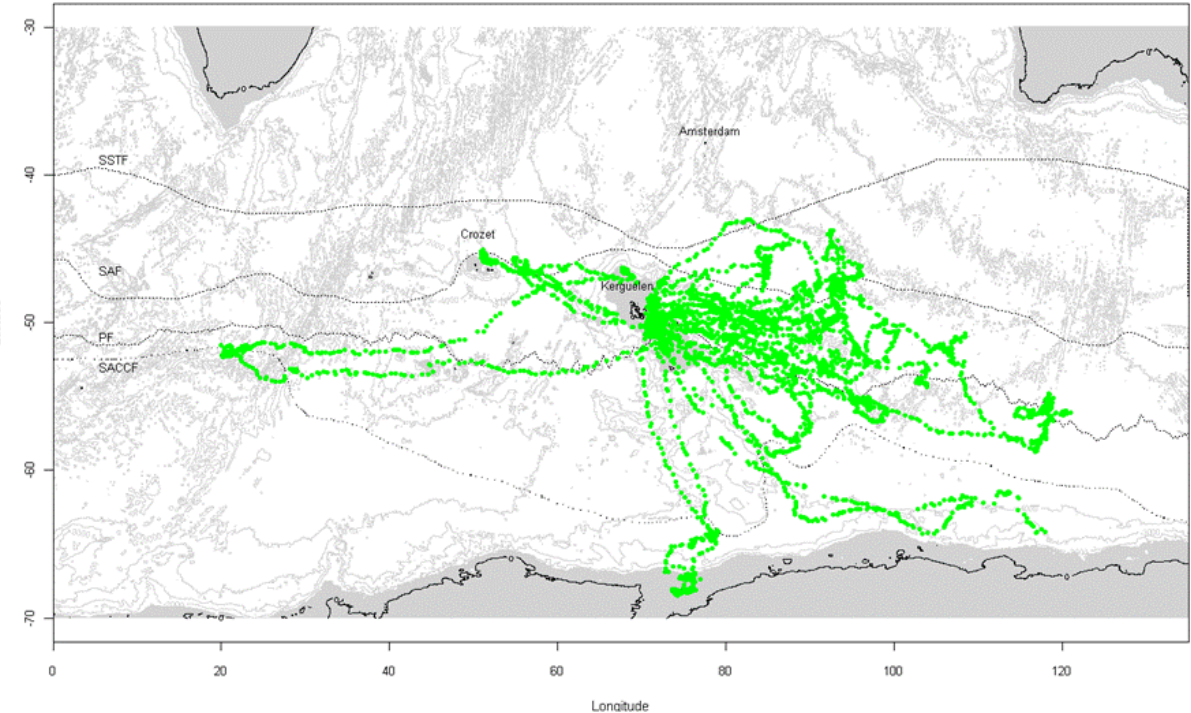
Figure 4. Location of the fluorescence profiles along the tracks of 24 SES successfully equipped with a CTD-FLUO-SRDL and collected within the scope of this study (December 2007–January 2011).